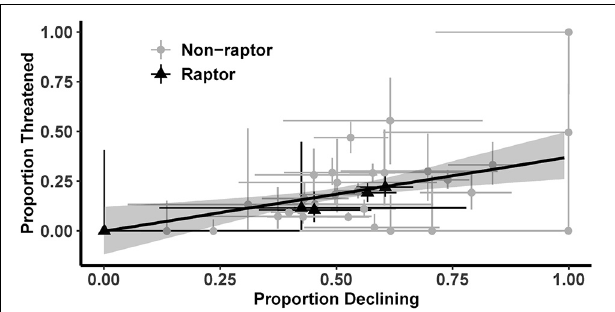
FIGURE 3 | Results of a linear regression between the proportions of threatened and declining species per order. Black line is the median prediction and gray shading is the 95% CRI.